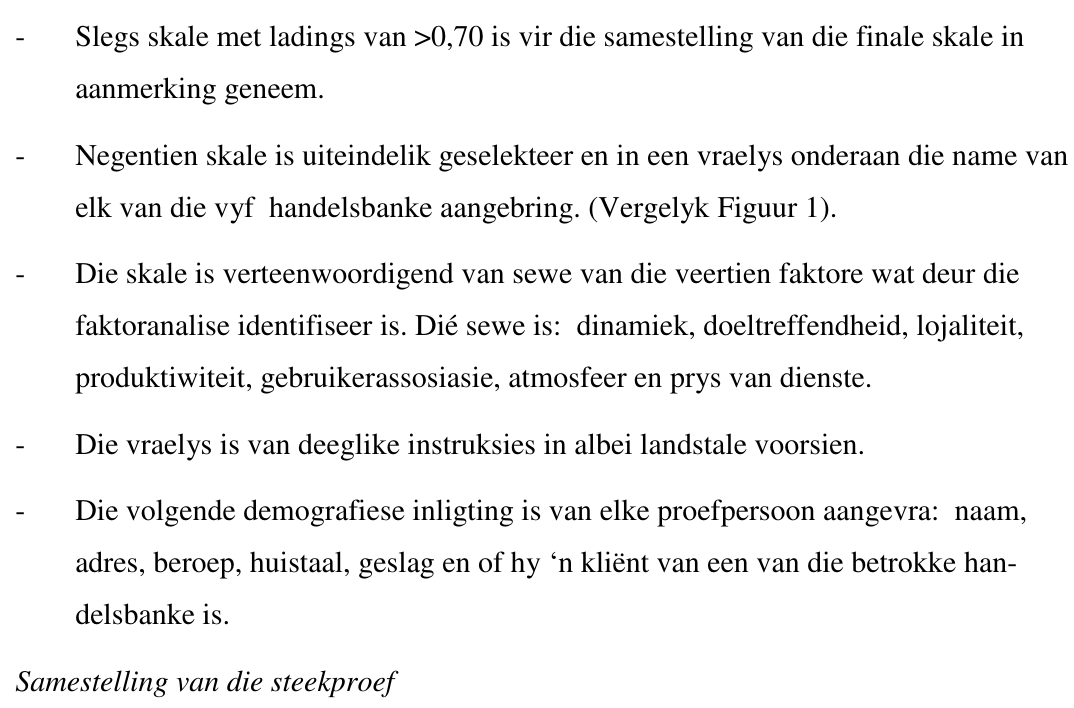
Faktor 10: Geslagsverbintenis Faktor 11: Fisiese aantreklikheid Faktor 12: Finansiële toerekenbaarheid Faktor 13: Prys van dienste Faktor 14: Sekuriteit FASE